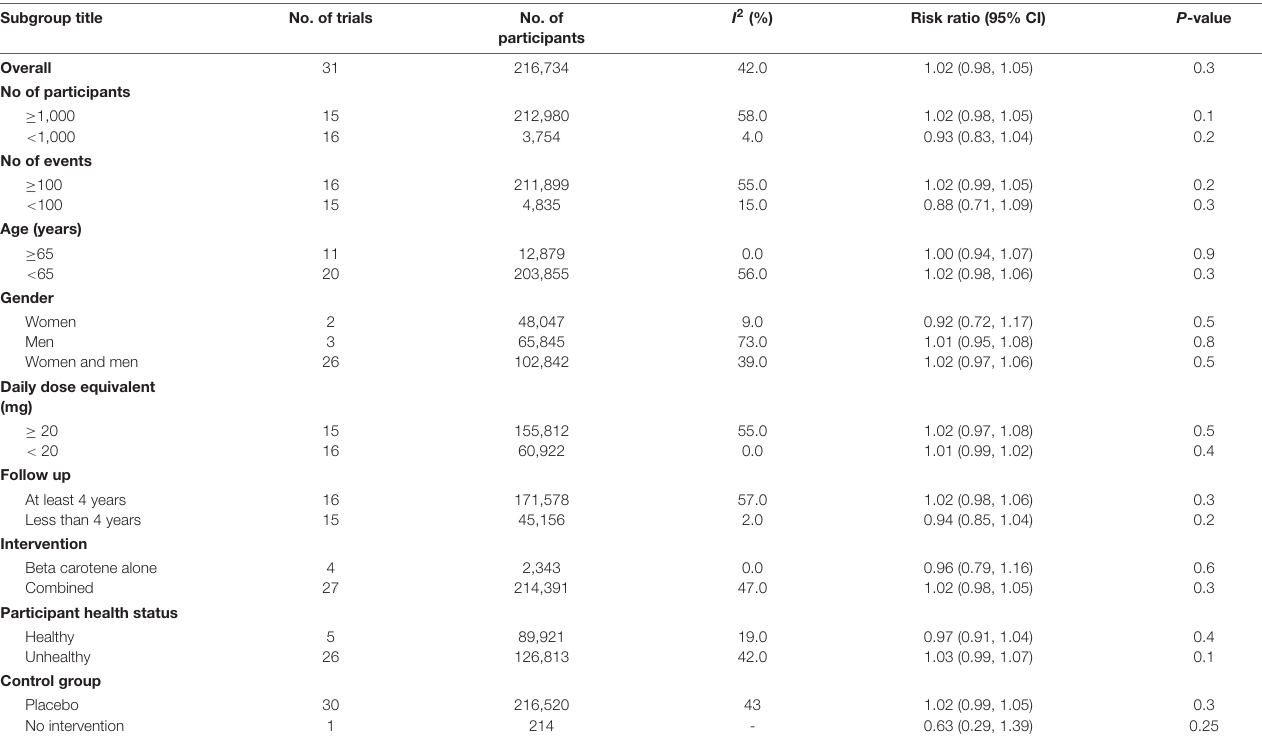
FIGURE 3 | Funnel plot for publication bias in 31 randomized controlled trials. TABLE 3 | Subgroup analyses of the effect of beta-carotene on total